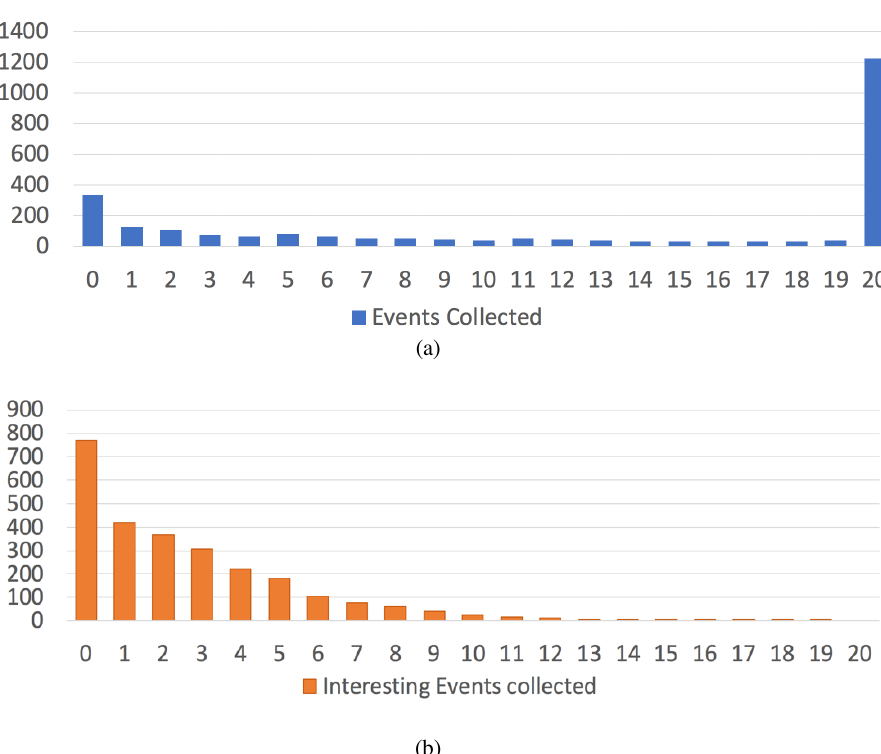
Fig. 4. Distributions of total number of events collected (a) and number of interesting events collected (b) over 2700